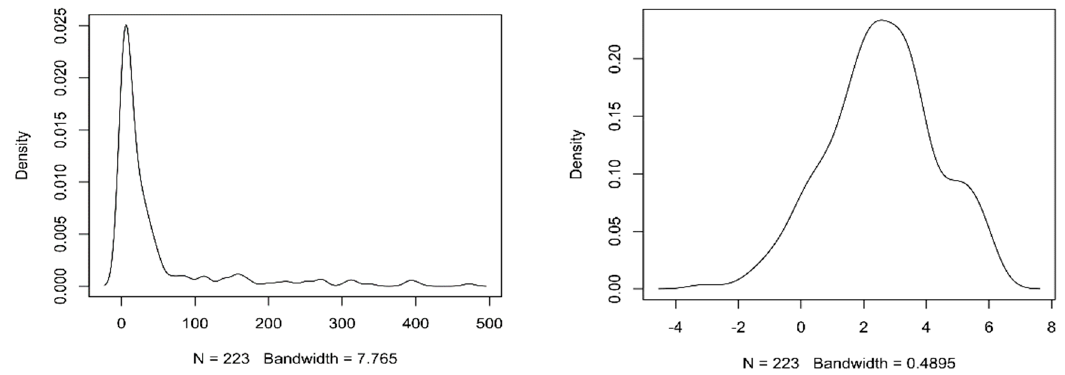
Figure 18. Density plot ( left ) and log-transformed density plot ( right ) for eye–key span.